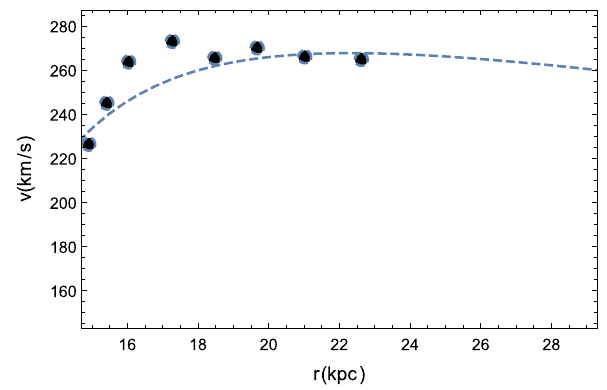
Fig. 3 Theoretical galactic rotation curve external to the typical vis- ible end of the Milky Way galaxy. The black dots show the observed galactic rotation curve in the outer region of galactic luminous disk of matter [60,61]. The dashed curve is the theoretical rotation curve in f ( R ) background beyond the galactic disk matter demonstrating that the galaxy can be treated as a point source having the typical mass ( 7 ± 2 . 5 ) × 10 11 M (cid:19) and galactic size (about 15 kpc). The plot is obtained for δ ≈ 10 − 6 with the galactic scale parameter r 0 = 10 2 . 623 kpc ≈ 419.280